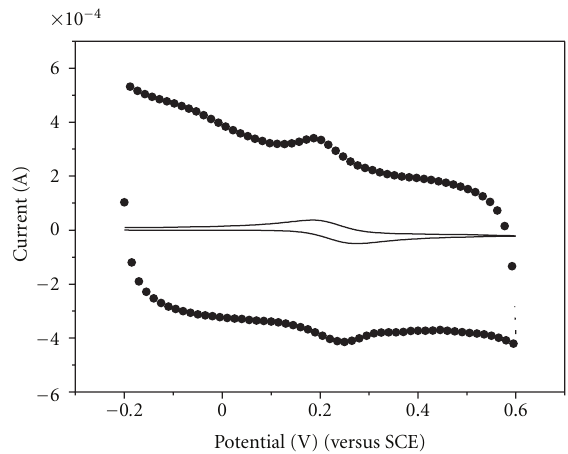
Figure 1: Cyclic voltammogram of 1mM K 3 Fe(CN) 6 at bare CPE (solid line) and poly (gabapentin) film-coated carbon paste electrode (dotted line) at 0.1 Vs − 1 scan rate.